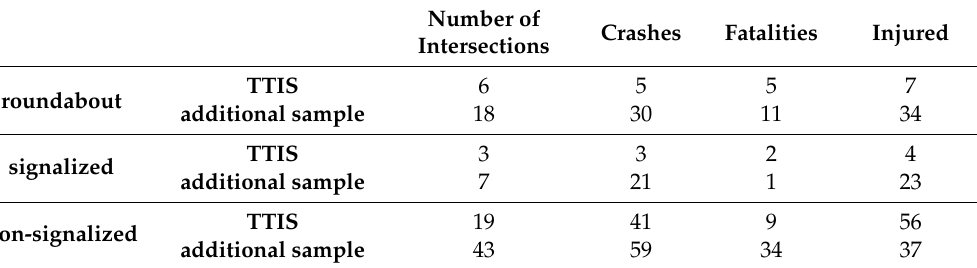
Table 2. Summary statistics of the intersection dataset.